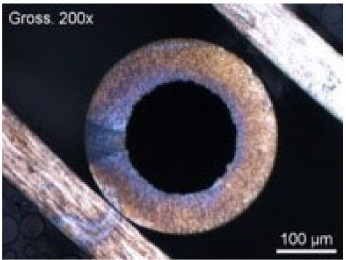
Figure 14. Weld in cross section: hypotube #8(ref) (scale = 100 µ m).